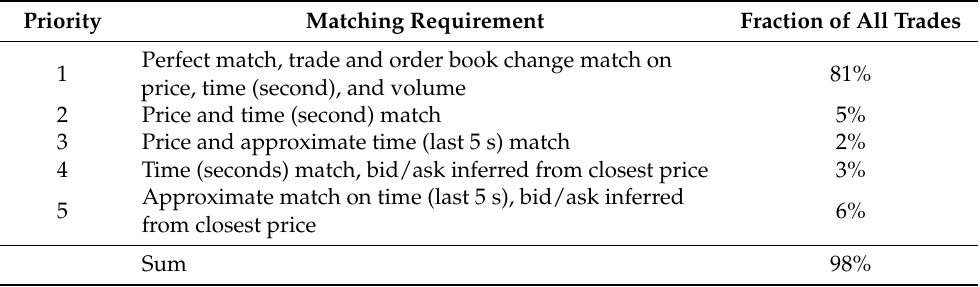
Table 1. Matching of trades and order book